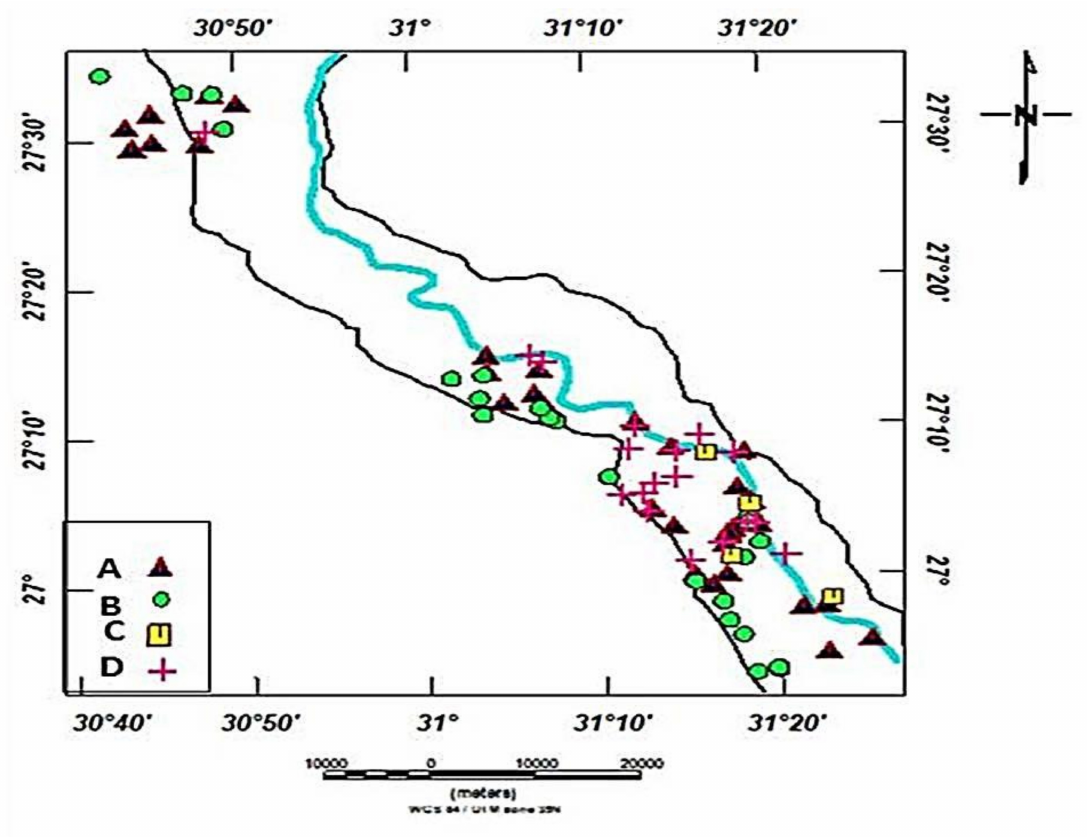
Figure 5. The location map of Assiut Governorate showing the stand distribution of the four